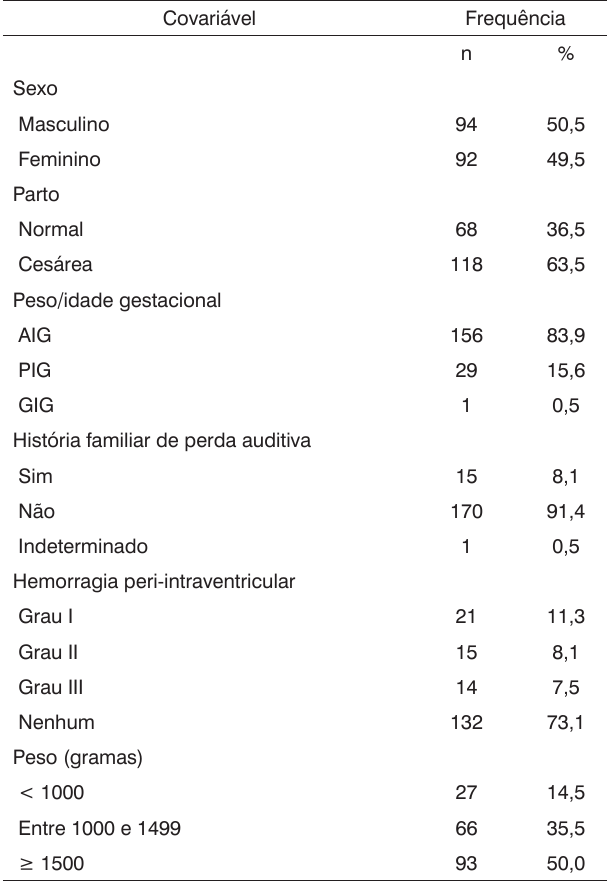
Tabela 1. Fatores perinatais da população